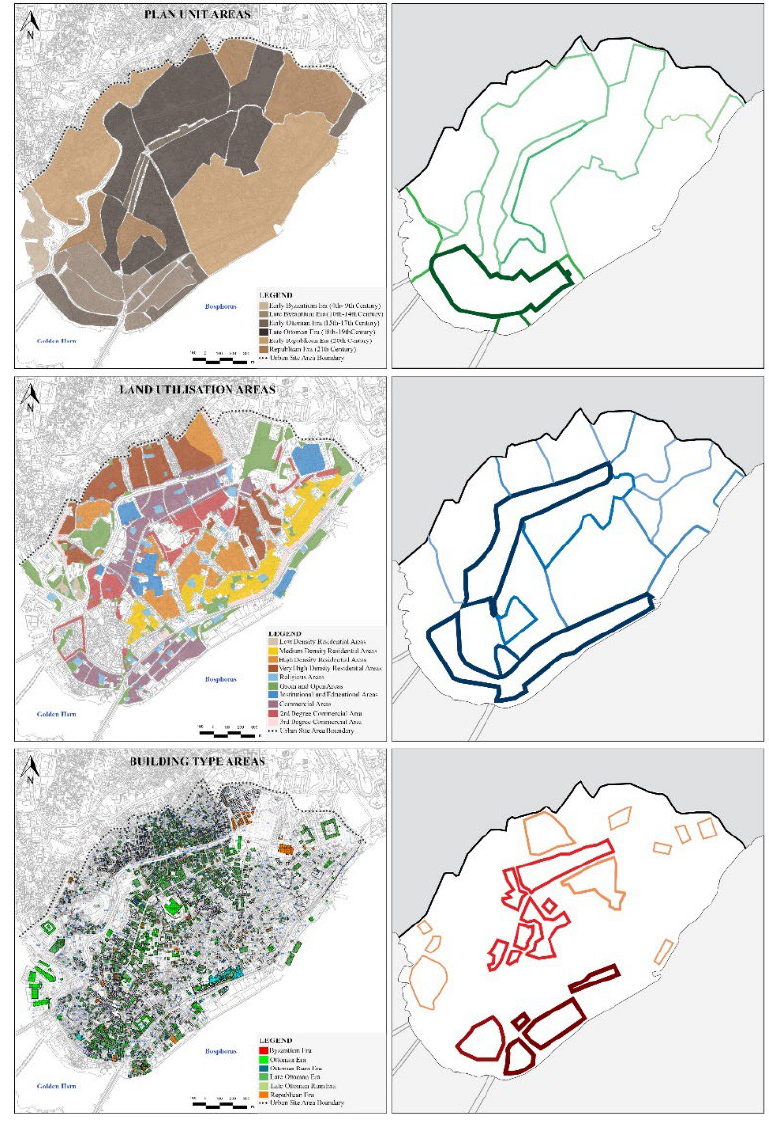
Figure 12 Plan unit, land utilization, and building type regions of Galata Region